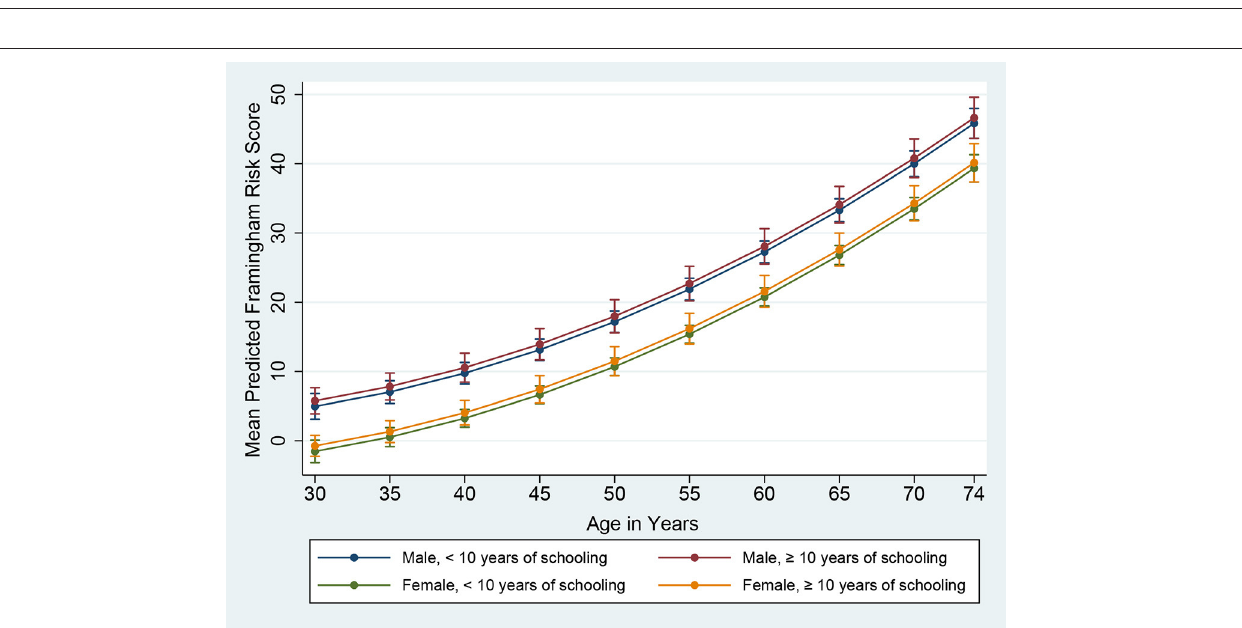
FIGURE 2 | Framingham Risk Score by age, gender, and education (vertical lines are means with 95% CIs).